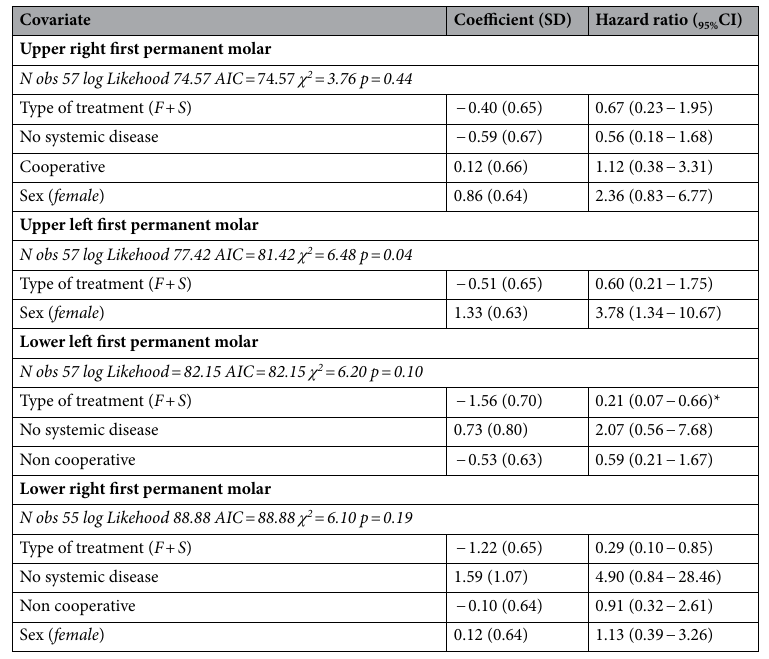
Table 3. Cox multiple logistic regression estimates of the change of status (sound vs affected by caries) at tooth level in low caries severity (1–3 lesions) cohort of FA and FA + S